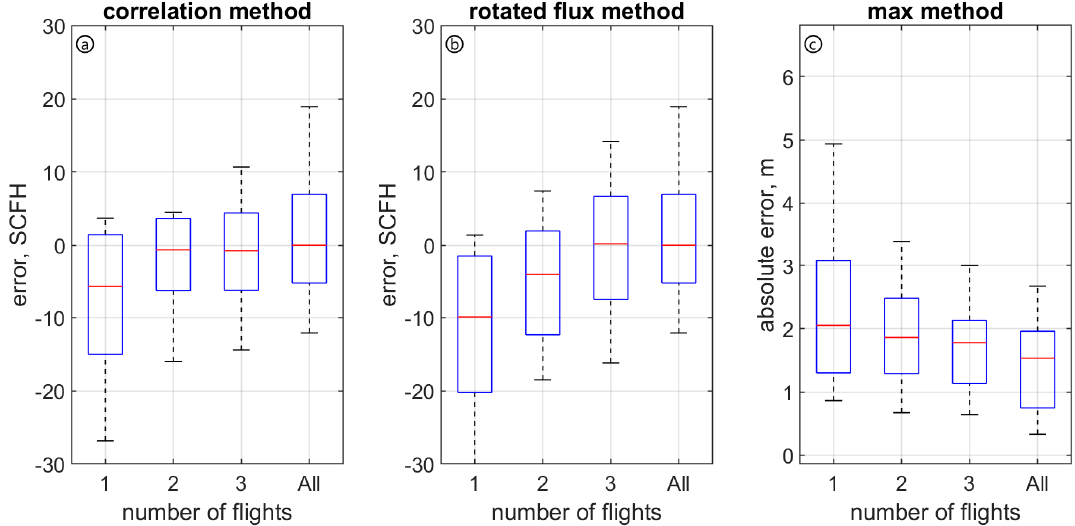
Figure 13. Effect on the number of flights on leak estimation accuracy, including quantification with the ( a ) correlation-based method and ( b ) rotated flux method, and localization with ( c ) the methane maximum method. On the x-axis is the number of flights included (1, 2, 3, or all flights available). The dataset includes all cases from Texas and METEC where at least 3 flights was available. The red line indicates the median, blue box the 25th and 75 percentiles, and dashed lines the 10th and 90th percentiles.